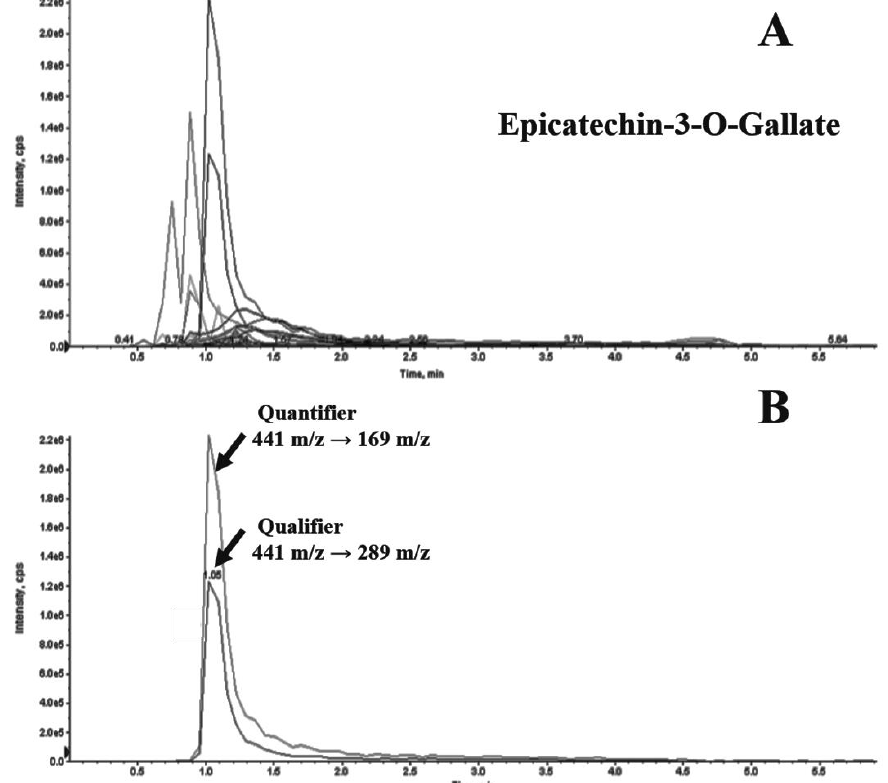
Figure 1. TIC chromatogram of a tea infusion sample ( A ) and MRM EIC of epicatechin 3-O-gallate ( B ). Quantifier 441 → 169 m/z and qualifier 441 → 289 m/z were reported.